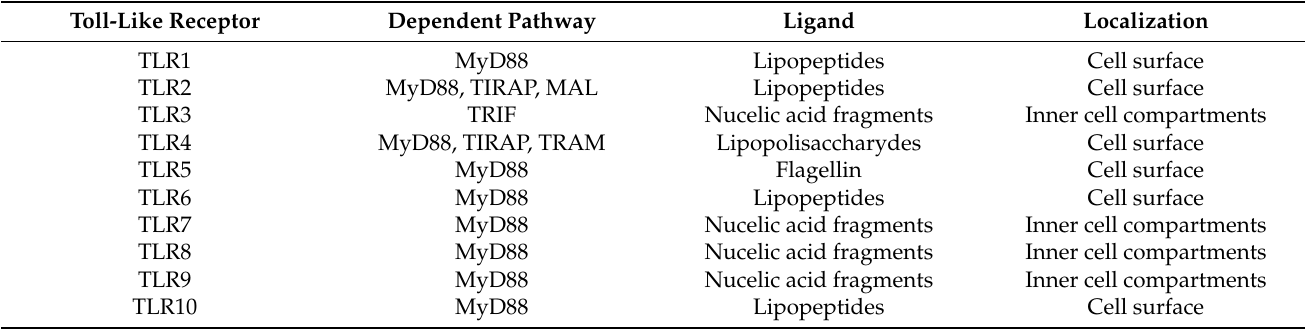
Table 4. Toll-like receptors with their pathways, ligands, and